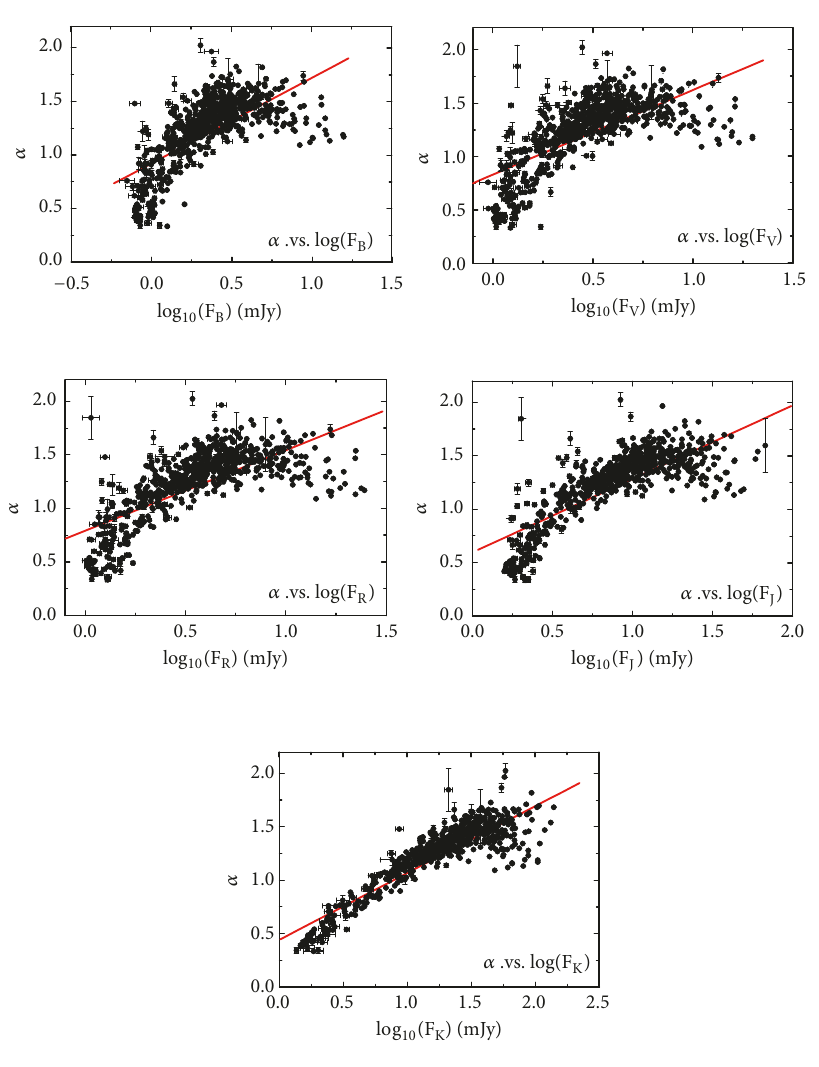
Figure 3: Relations between the logarithmic flux densities (log 𝐹 ] ) and optical spectral indices ( 𝛼 ). The red lines stand for the linear fitting.